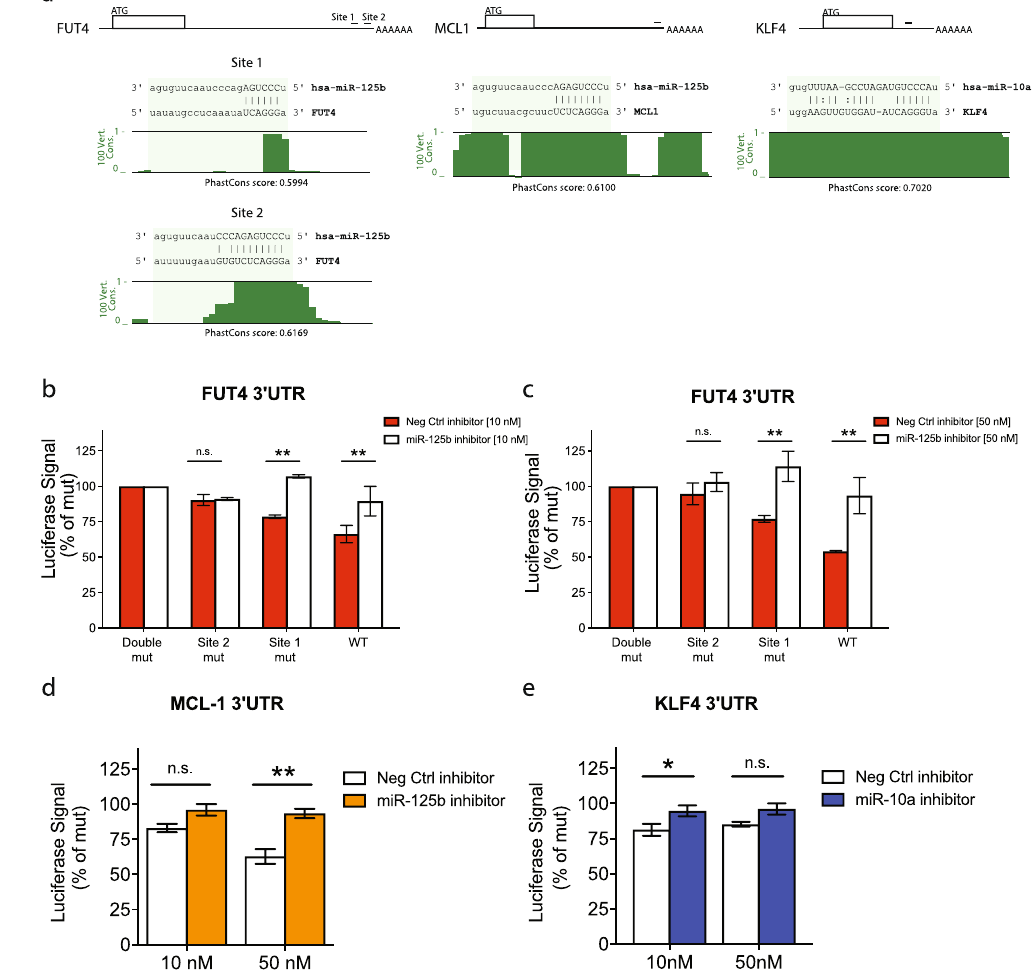
Figure 5. Gene targets of miR-125b and miR-10a. Luciferase reporter assays performed in HeLa cells transfected with the WT or mutated 3 ′ UTR binding site from ( a ) MCL1 , ( b , c ) FUT4 or ( d ) KLF4 . The 3 ′ UTRs were cloned into a pSiCHECK2 vector and transfected with or without a specific inhibitor of mir-125b/ miR-10a or a non-specific control at 10 nM or 50 nM. The one predicted binding site in the MCL1 and KLF4 3 ′ UTRs were tested, while the two binding sites in FUT4 were each tested alone (Site 1 mutant and Site 2 mutant) and together (Double mutant). Each experiment was performed 3 times, each in triplicate. Graphs show mean ± SEM. Groups were tested by a two-way ANOVA with Bonferroni post tests. ** p ≤ 0.01, * p ≤ 0.05, n.s. = not